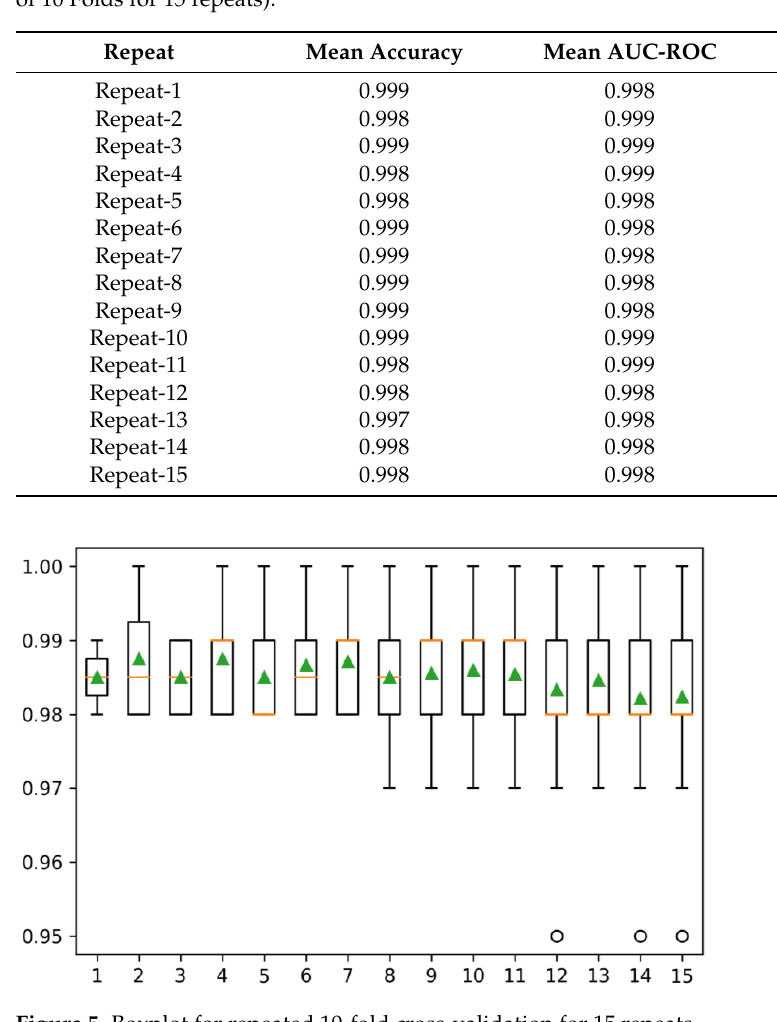
Figure 5. Boxplot for repeated 10-fold cross-validation for 15 repeats.